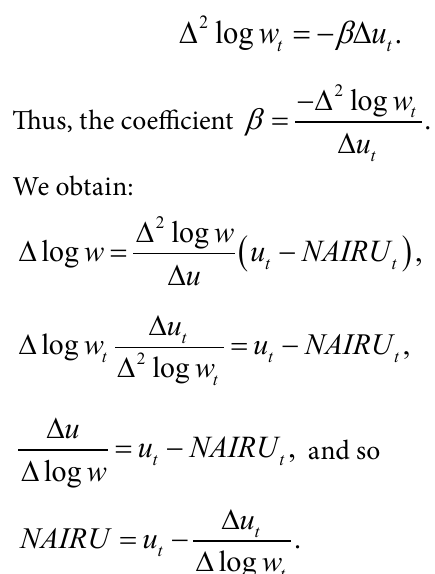
6,0%7,0%8,0%9,0%